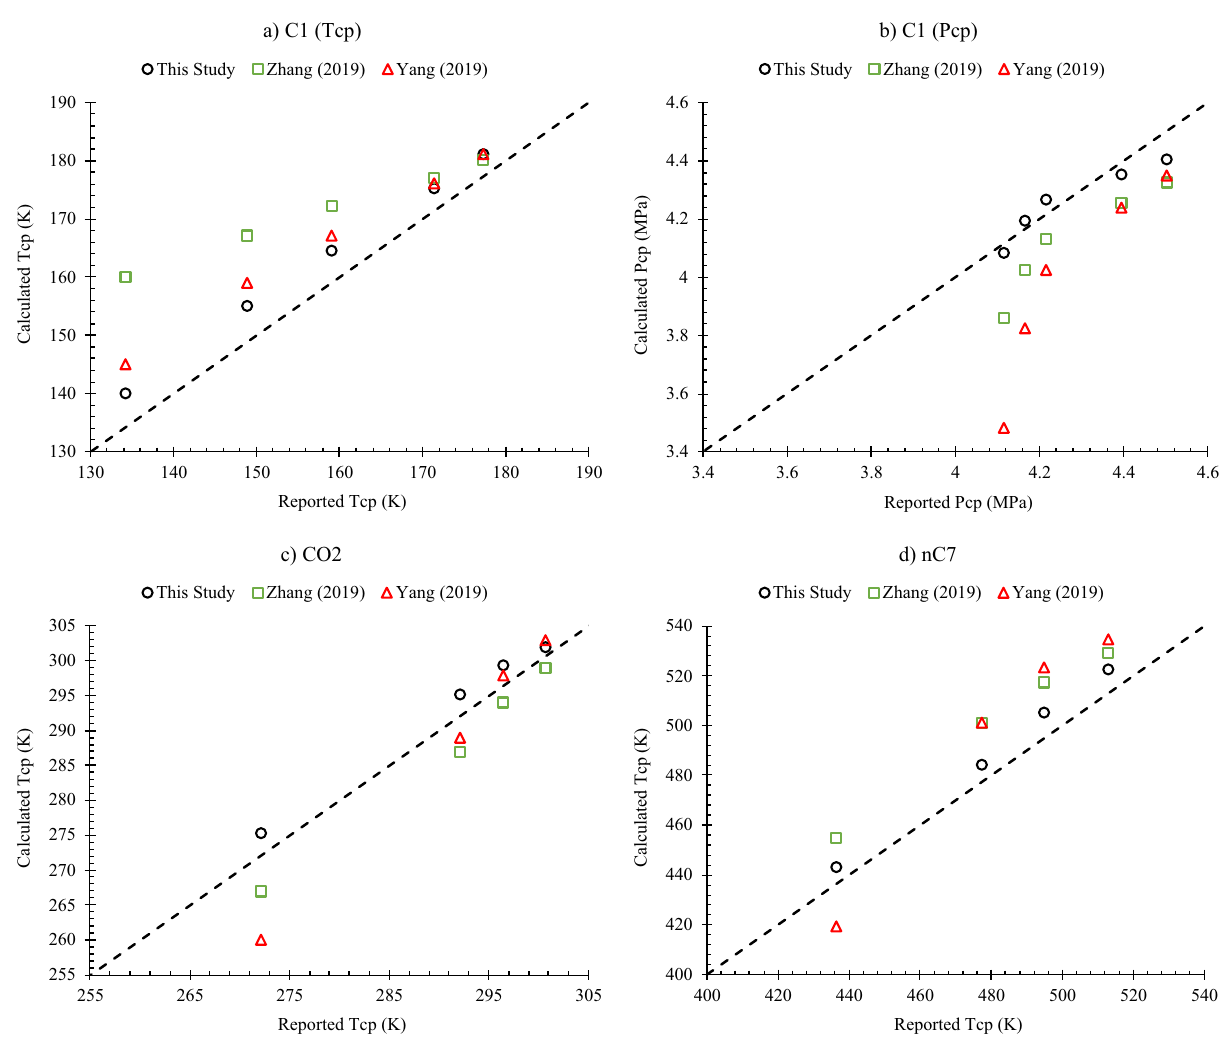
Figure 11. Cross plots of critical shift estimations from this study along with two other models in the literature 23,31 for ( a , b ) methane 46, ( c ) carbon dioxide, and ( d ) normal heptane